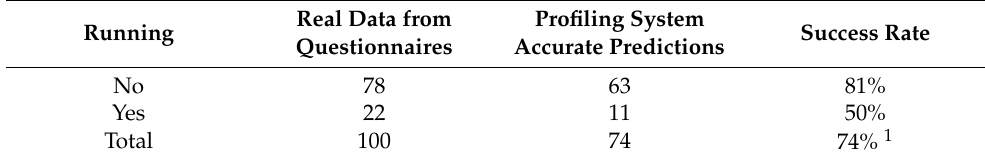
Table 4. Running